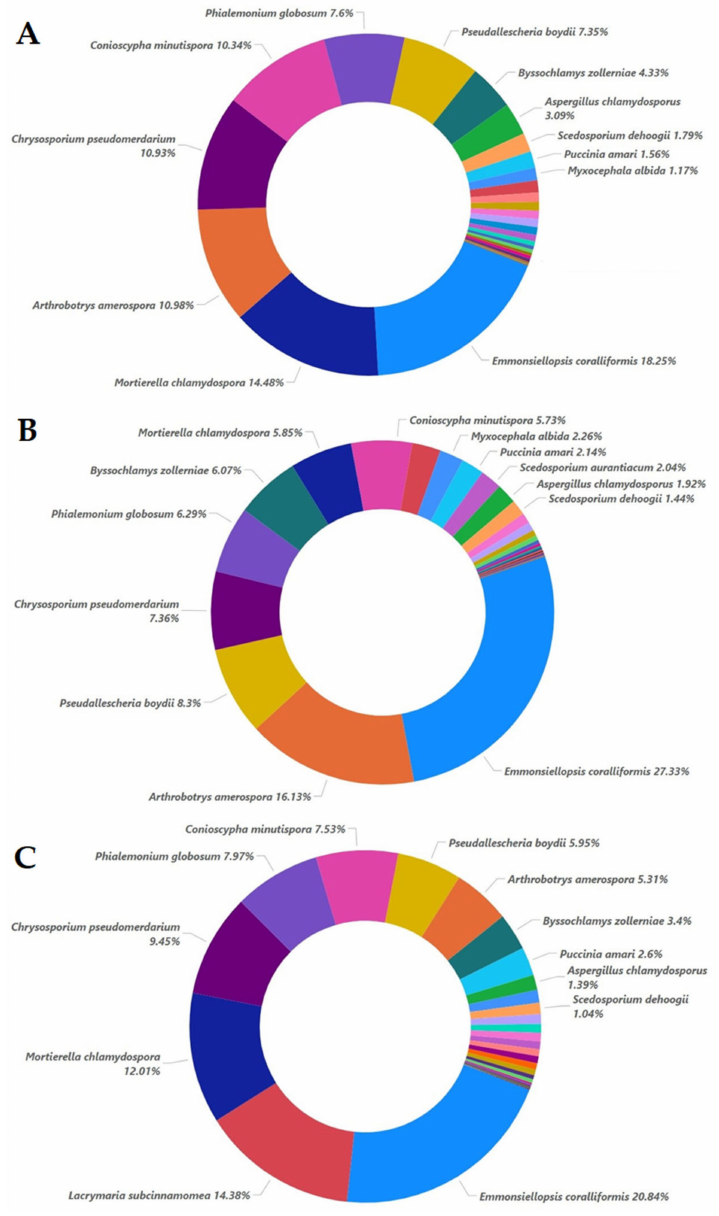
Figure 9. Relative species abundance with percentages higher than 1% for the non-inoculated samples at 0% ( A ), 5% ( B ), and 20% ( C ) essential oil